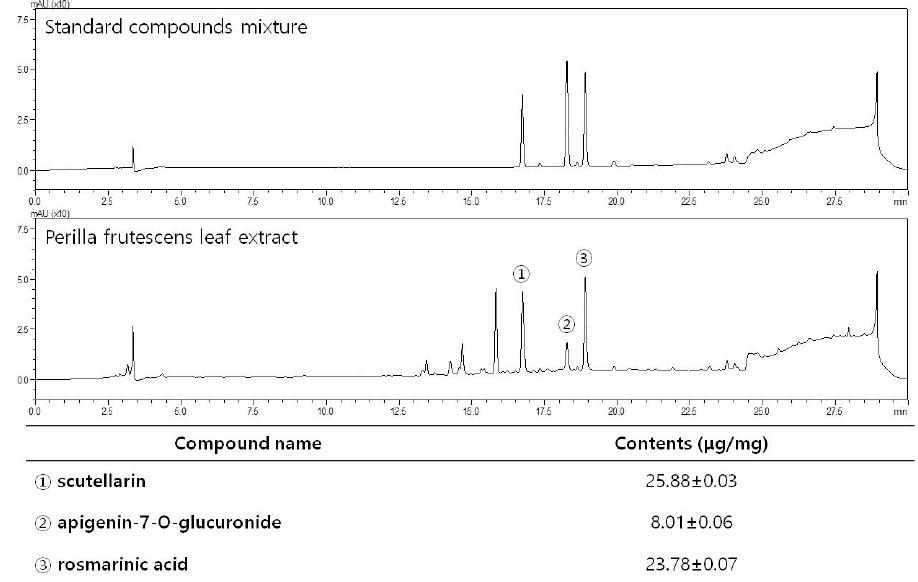
Figure 1. HPLC chromatograms of a standard mixture of scutellarin, apigenin-7-O-glucuronide, and rosmarinic acid, and Perilla frutescens leaf extract obtained using a YMC Triart C18 column monitored at 254 nm of peak area, 30 min of run time, 1.0 mL/min of flow rate. Peaks of scutellarin, apigenin-7-O- glucuronide, and rosmarinic acid are indicated with circled numbers “1”, “2”, and “3”,